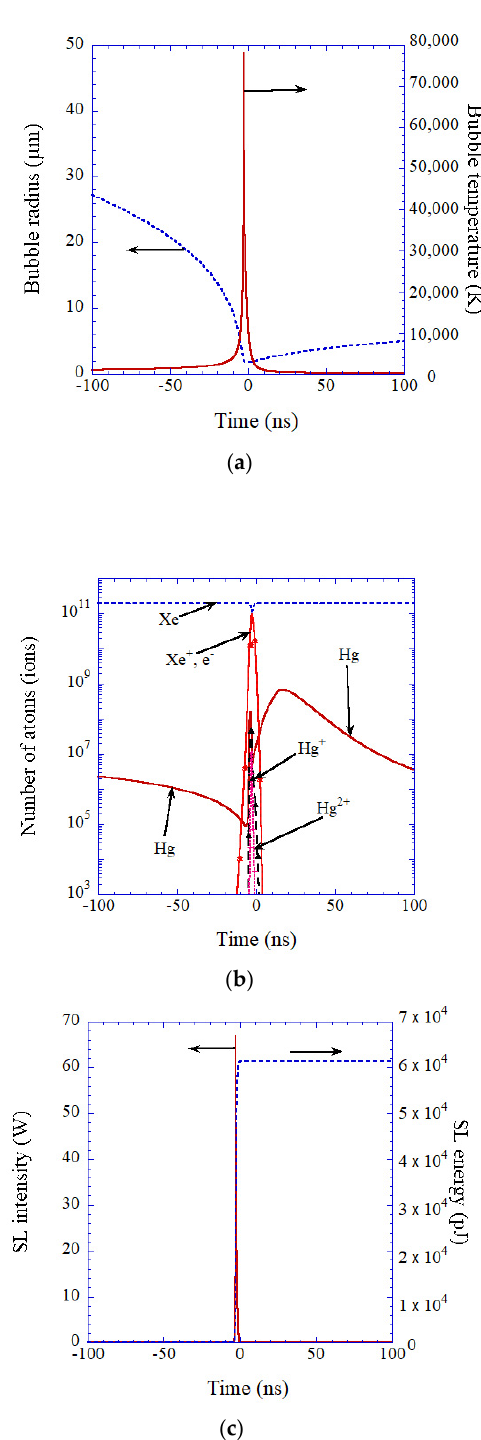
Figure 36. The result of numerical simulation for a Xe bubble in mercury as a function of time for 200 ns near the end of the bubble collapse (R 0 = 10 μ m, S = 10 5 m − 1 ) [42]. ( a ) The bubble radius (dotted line) and the temperature inside a bubble (solid line). ( b ) The number of atoms (ions) inside a bubble with logarithmic vertical axis. ( c ) The SL intensity (solid line) and its time integral (dotted line). Copyright 2012, with permission by the American Physical Society.